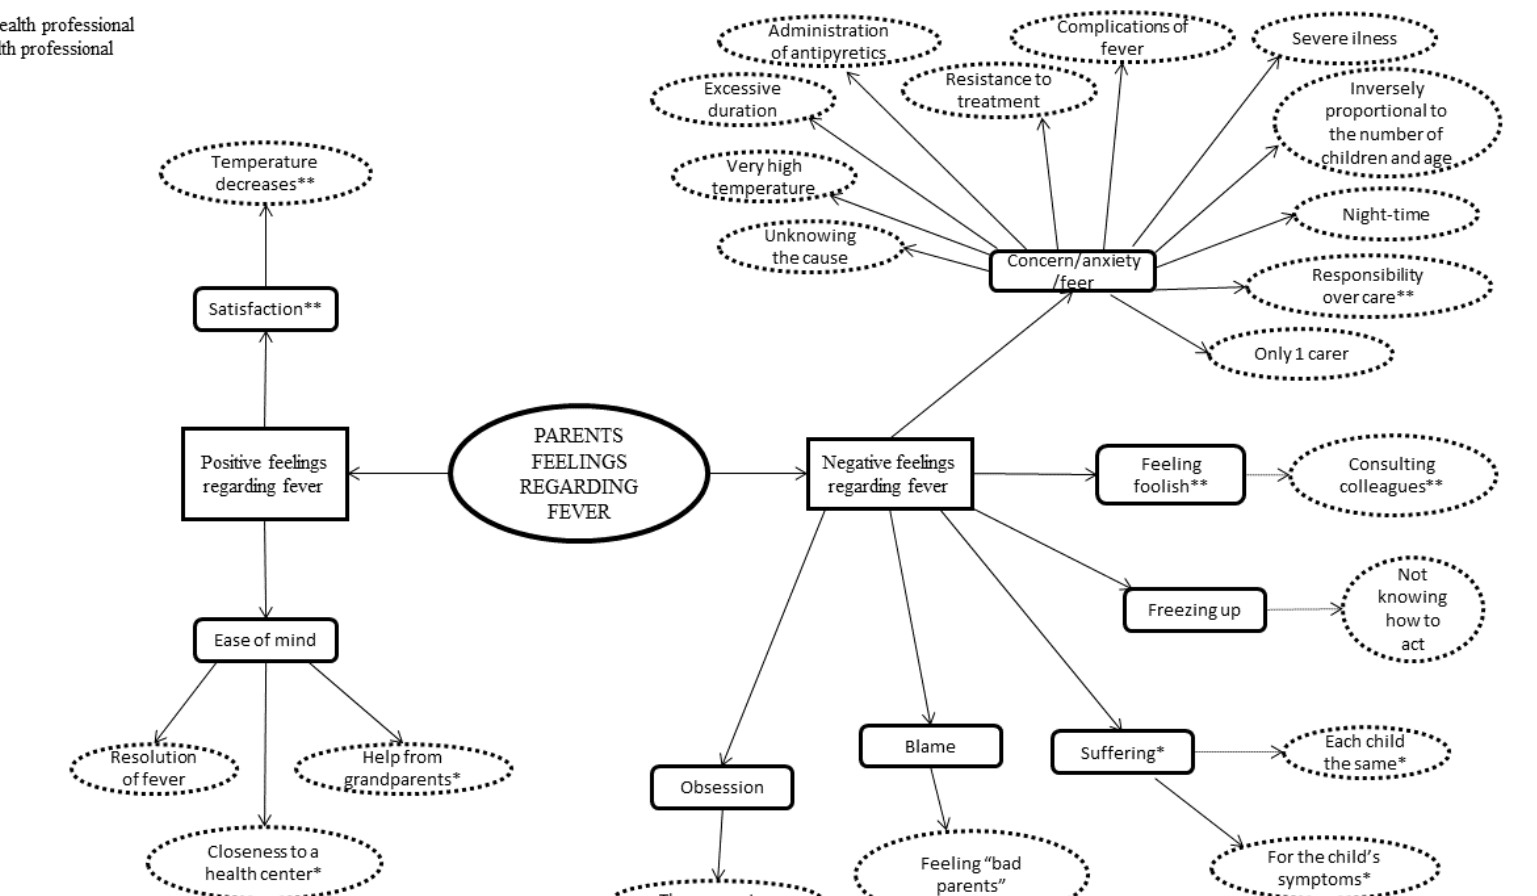
Figure 2. Parents’ ambivalent feelings regarding their child’s